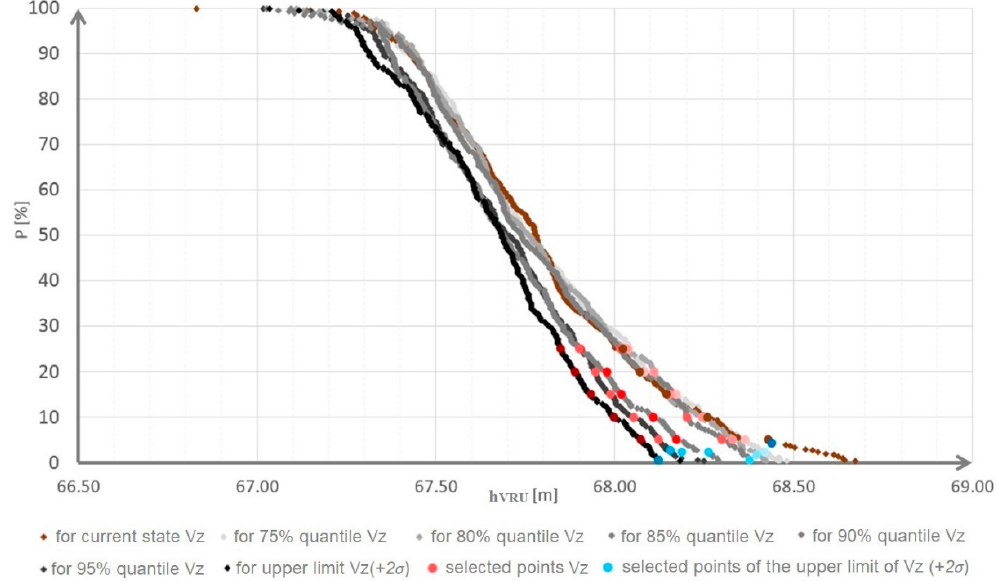
Figure 10. Lines indicating the probabilities of exceeding the calculated water height peaks in the reservoir during the transformation of the uncertain flood discharge Q 1000 for selected optimized storage volumes.